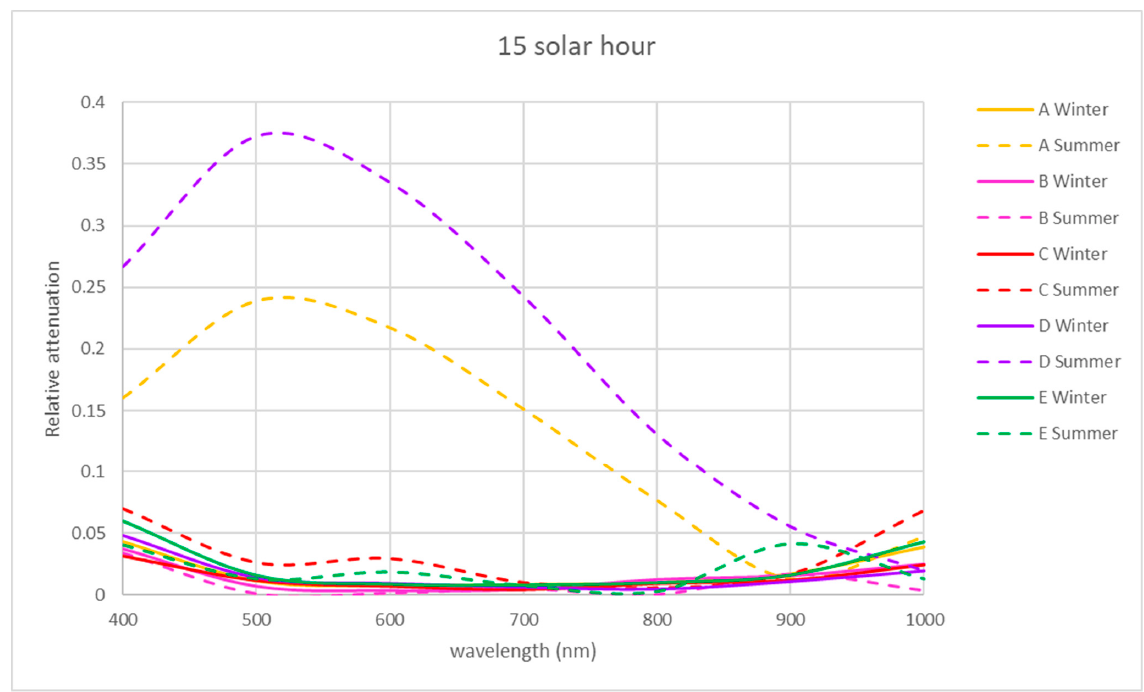
Figure 10. Representation of the spectral relative attenuation for the VIS and NIR bands for the 5 locations studied in two seasons of the year at 15 solar hours.